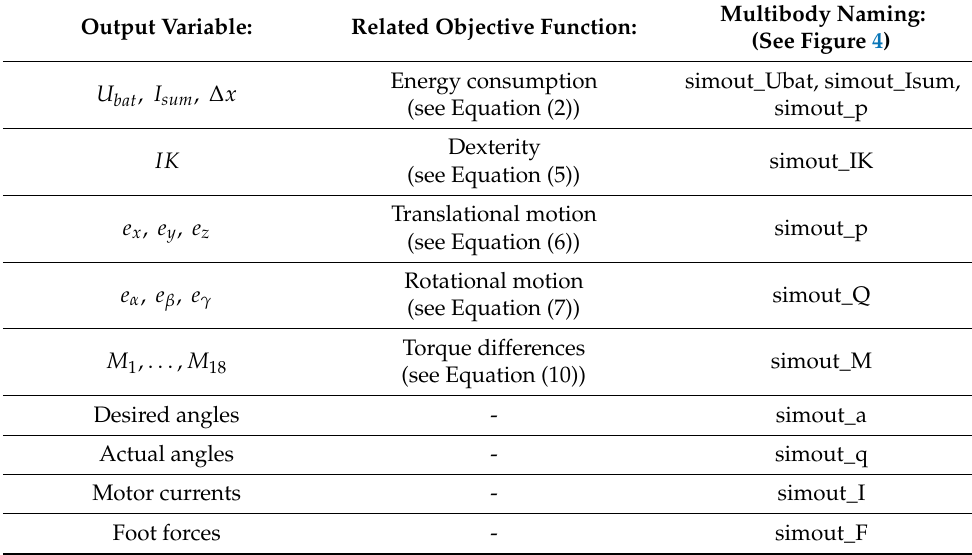
Table 3. The output variables generated by the simulation